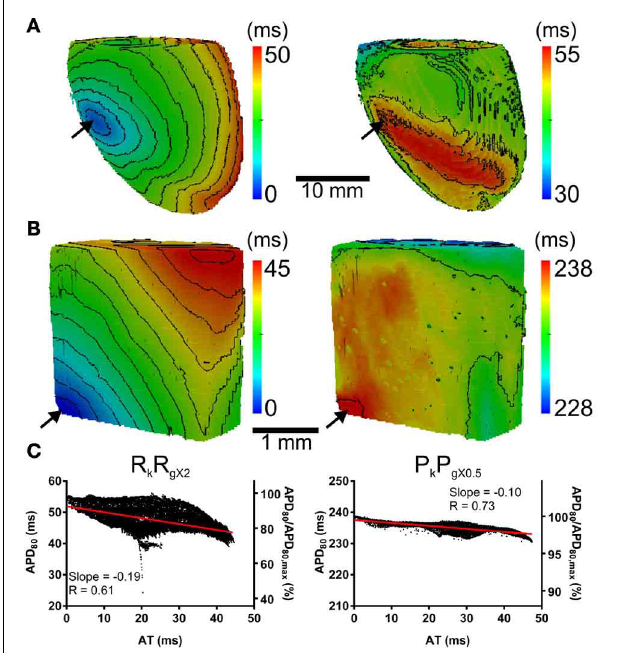
FIGURE 8 | The influence of tissue geometry on the dispersion of APD. Ventricles were paced at the mid-anterior insertion site of rat and apex of pig geometries (arrows). Panels are maps of AT (left panels) and APD (right panels). (A) Dimensions of rat geometries were increased by a factor of two (R k R gX2 ). (B) Pig kinetics were simulated in a pig geometry with dimensions scaled by half (P k P gX0 . 5 ). Isochrones are 4ms for all maps. (C) AT-APD plots for R k R gX2 (left panel) and P k P gX0 . 5 (right panel) simulations. Slopes of linear correlation analyses are indicated. Secondary y -axes show APD 80 expressed as a percentage of maximum APD 80 .